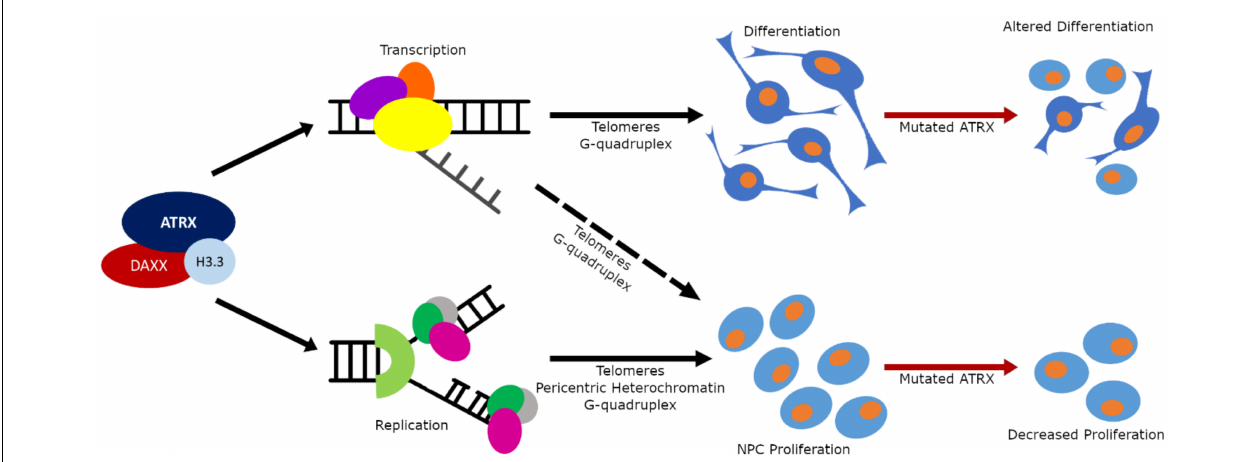
FIGURE 3 | The multiple functions of the ATRX protein. Schematic diagram of ATRX functional influence on brain development and its contribution to NDDs. Normally ATRX utilizes its chromatin remodeling activity to (1) influence transcription and DNA replication in heterochromatic regions to control the rate of proliferation in the neuronal progenitor cell population (bottom arm); and (2) to influence transcription in heterochromatic regions to control differentiation processes (top arm). When ATRX is mutated the cellular proliferation rates in progenitors is slowed resulting in a smaller progenitor population; and the differentiation processes are altered resulting in either dysfunctional cellular morphology or complete absence of specific cell